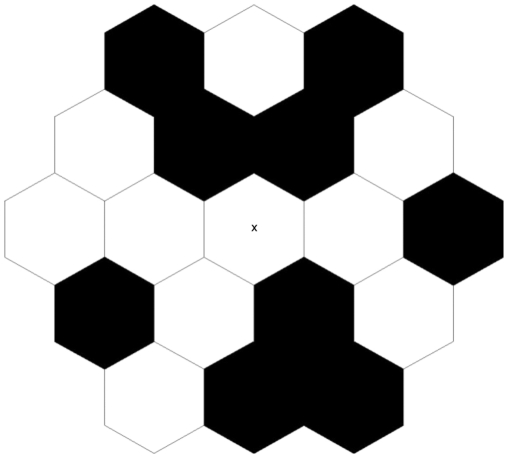
Multifocal stimulus consisted of 19 close-packed uniform hexagons presented in pseudo-random temporal sequence (dark/light grey, 24% contrast; black/white, 96% contrast) using a 75 Hz frame rate CRT monitor.